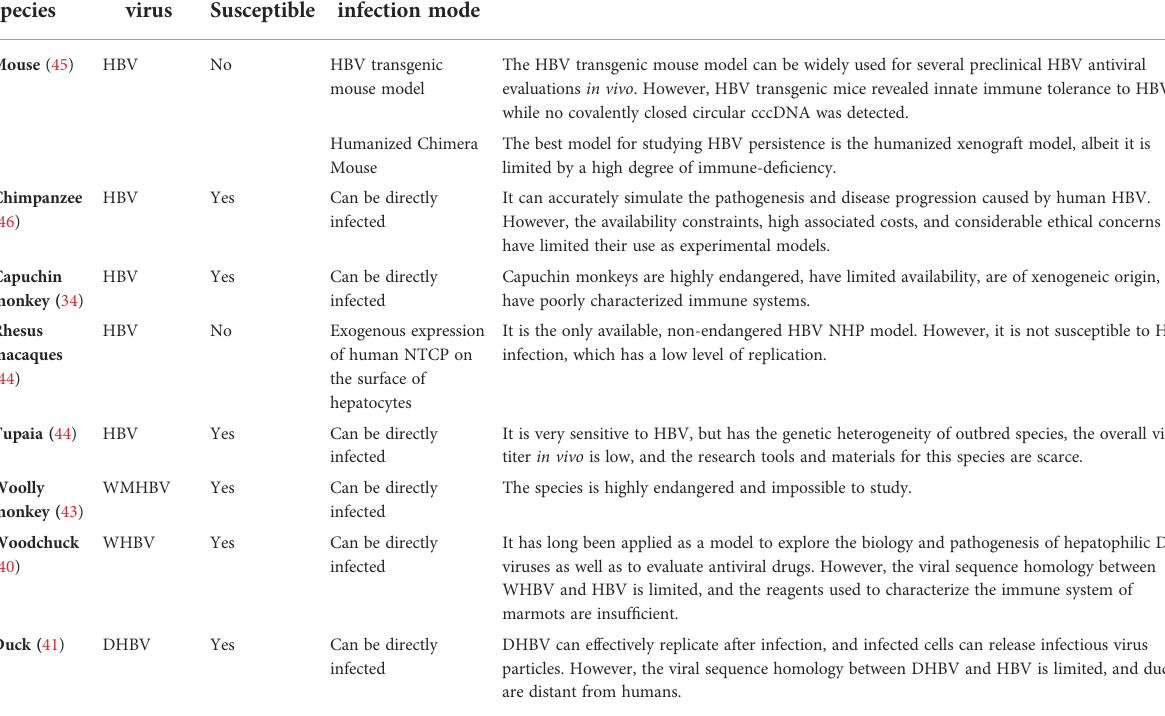
TABLE 1 Animal models for HBV researches. Animal